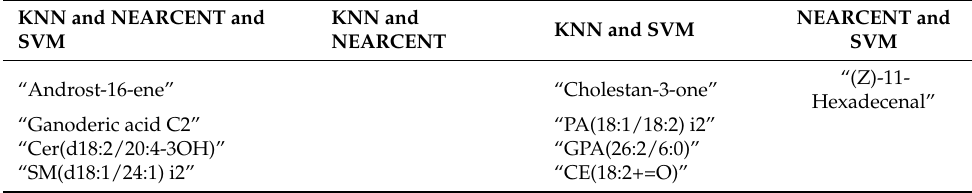
Figure 16. Evolution of maximum fitness scores over generations, using the T2DM-DN dataset. The vertical axis represents the fitness score, while the horizontal axis represents a given generation. The solid blue line represents the average fitness across all models. The average unfinished fitness is plotted as a solid cyan line and represents the average worst case expectation for all failed searches in a given generation. The red dotted line shows the established GA goal fitness. Table 12. Common metabolites found in each model for Control-Diabetes.